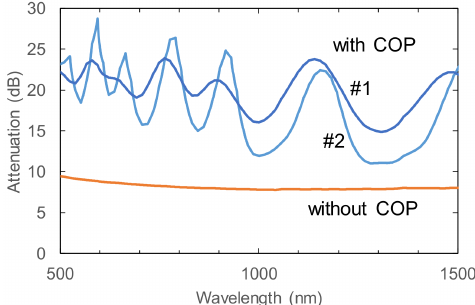
Figure 4. Loss spectra of cyclic olefin polymer (COP)-coated hollow fibers in the visible to near-infrared region before and after removal and re-coating of the COP